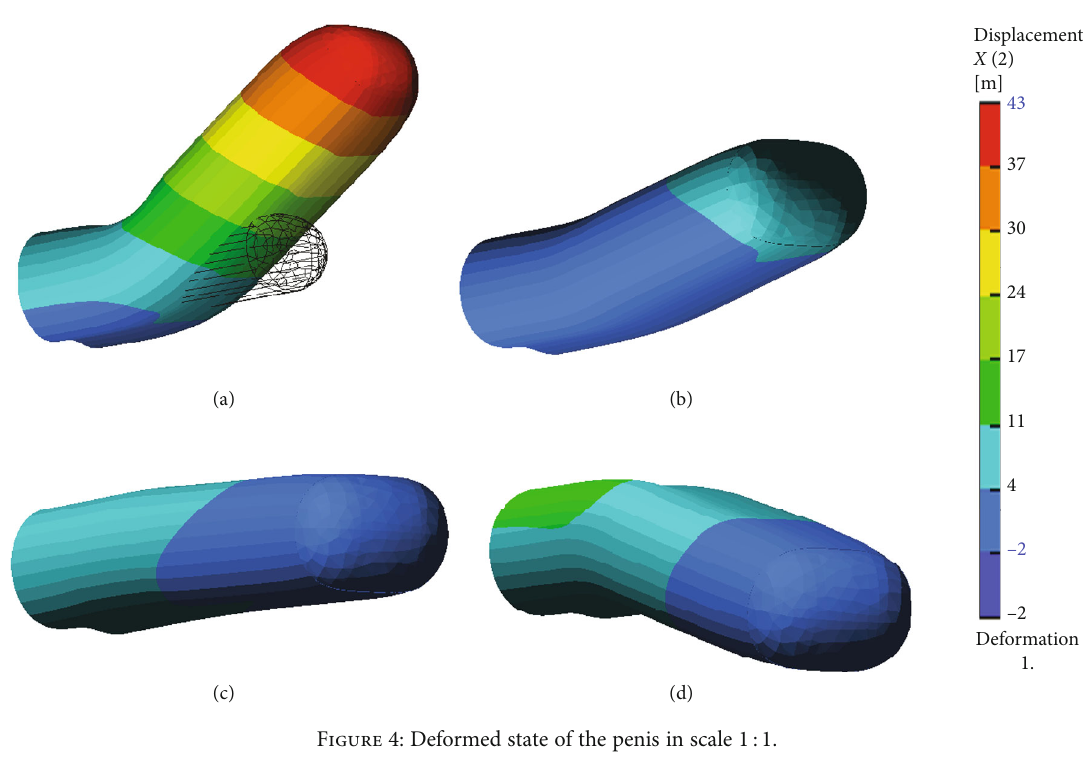
Figure 4: Deformed state of the penis in scale 1:1.